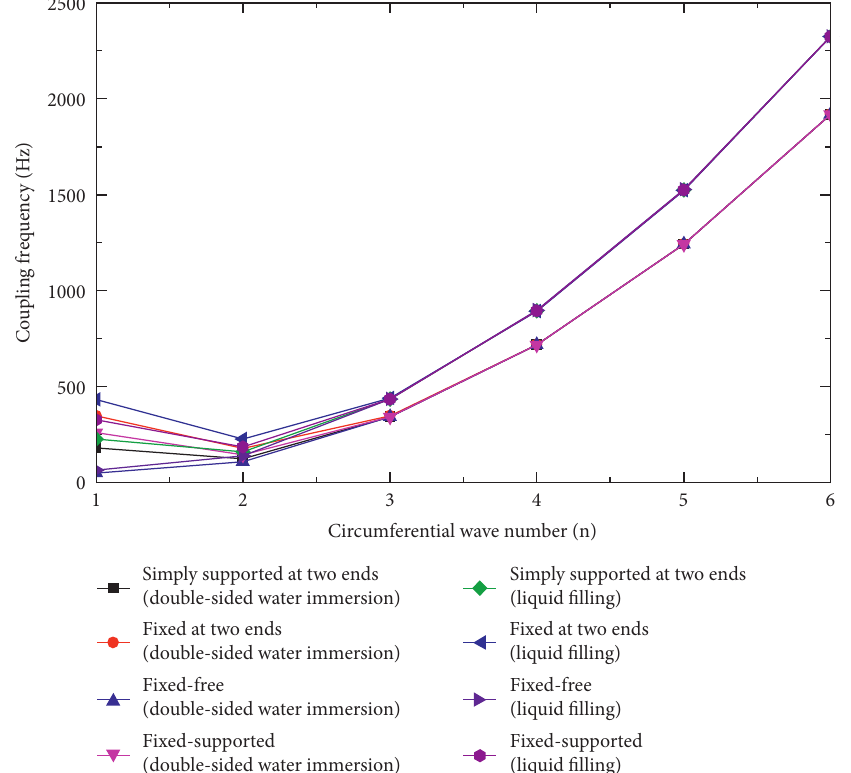
Figure 7: Coupling frequency curves of different boundary conditions.